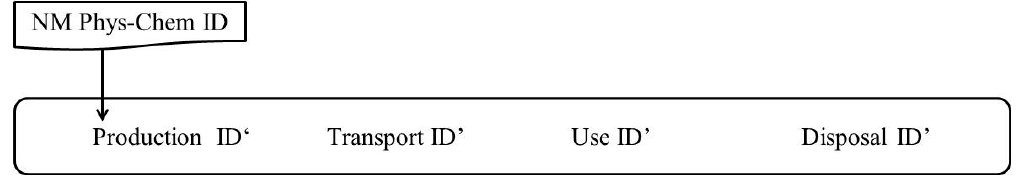
Figure 4. The NMs should be characterised in each point over the entire life cycle, here exemplified by four life cycle steps.